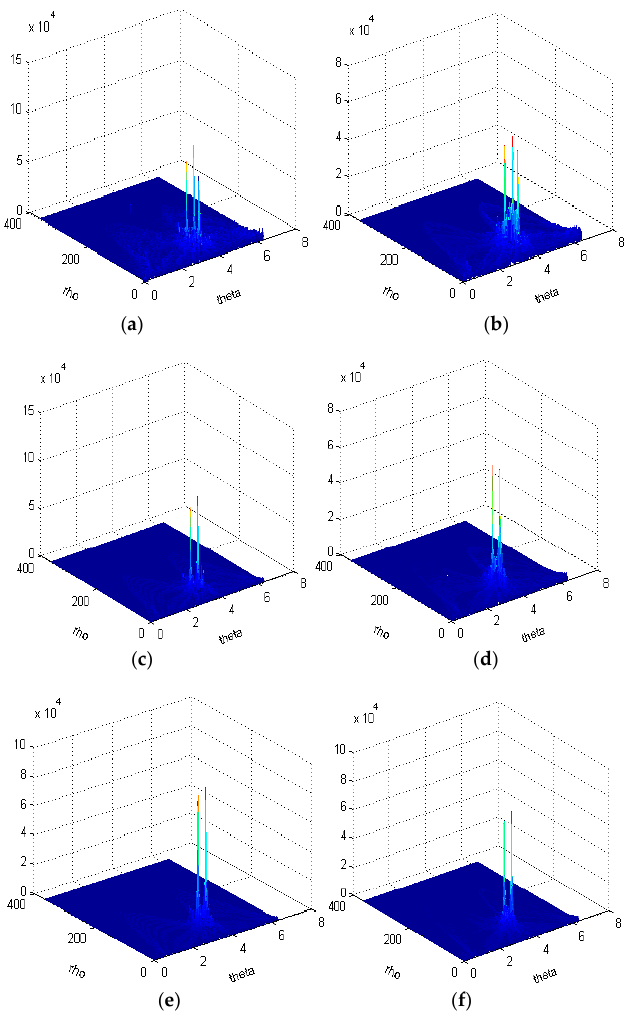
Figure 5. The Hough transform of WVD and RSPWVD with BDS B1I signals corrupted by two chirps, C 0 / N is 43 dB-Hz. ( a ) Hough transform of WVD, JNR is 0 dB. ( b ) Hough transform of RSPWVD, JNR is 0 dB. ( c ) Hough transform of WVD, JNR is 6 dB. ( d ) Hough transform of RSPWVD, JNR is 6 dB. ( e ) Hough transform of WVD, JNR is 12 dB. ( f ) Hough transform of RSPWVD, JNR is 12 dB.